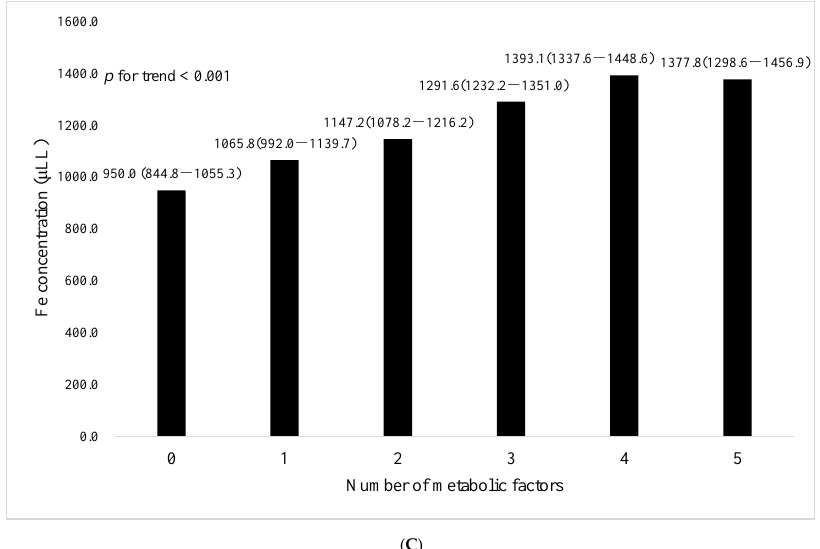
Figure 1. Comparison of serum concentrations of ( A ) zinc, ( B ) copper, and ( C ) iron in relation to the number of metabolic factors. The least square means of serum zinc, copper, and iron increased with the increase in the number of metabolic factors after adjusting for age, sex, current smoking, current drinking, and exercise habit. ( p for trend < 0.001).